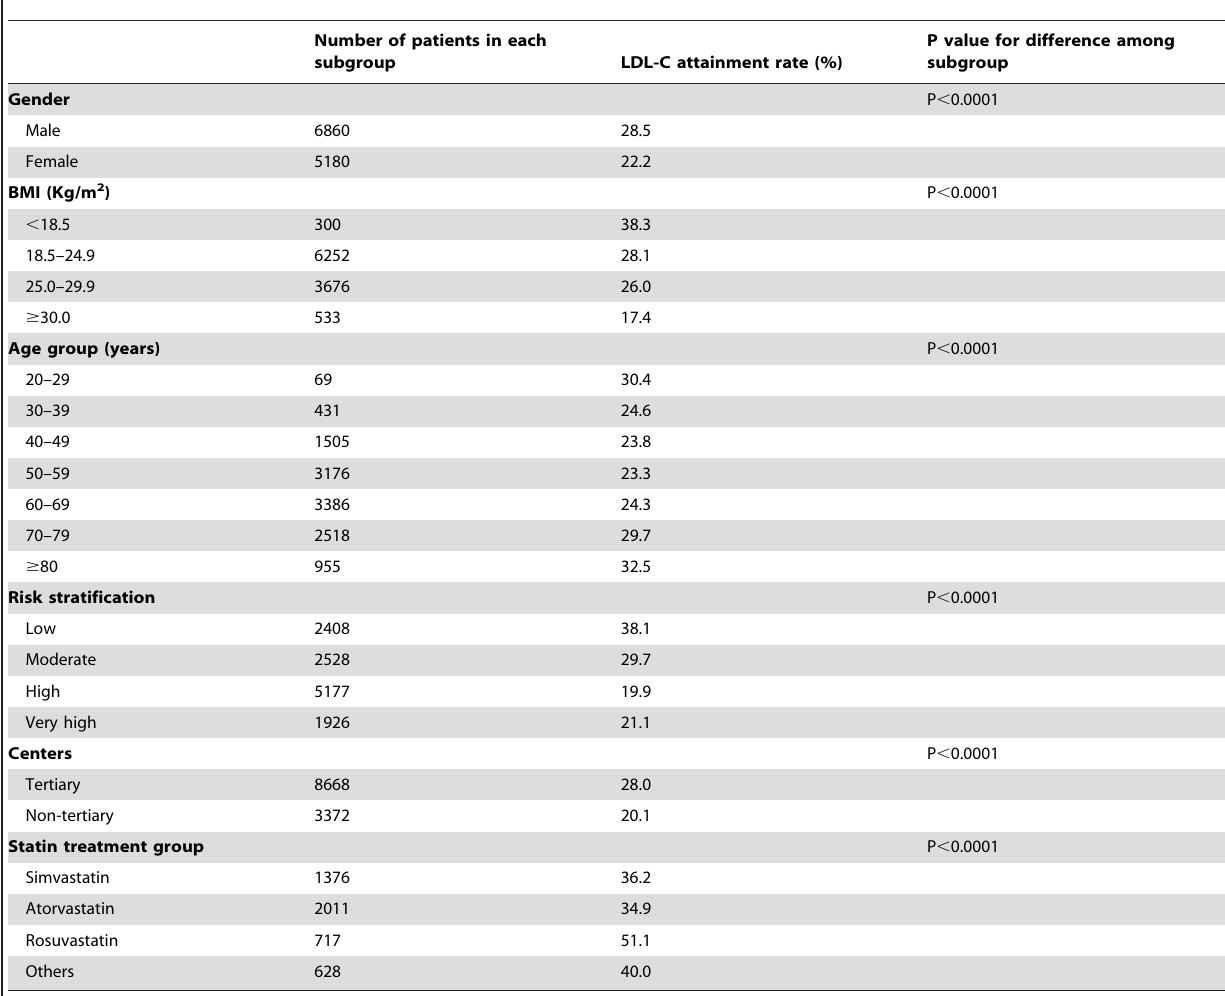
Table 3. Attainment of recommended cholesterol targets in each subgroup.